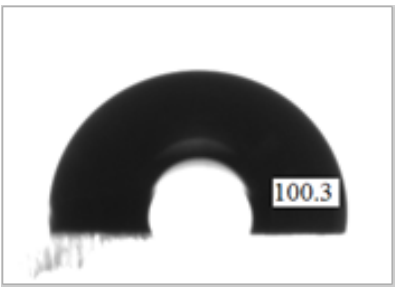
Figure 7. Water contact angle of a plane PDMS.